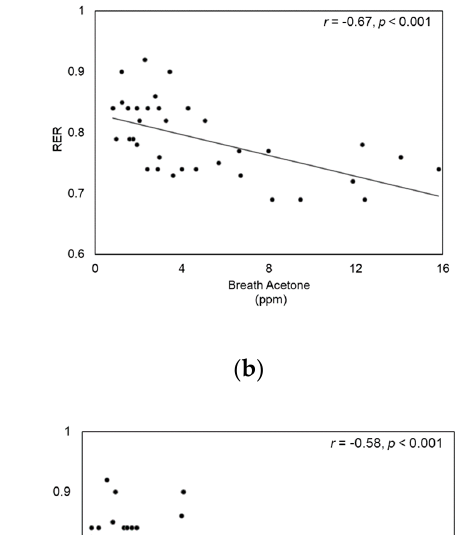
Figure 2. Monitoring of ( a ) Breath acetone, ( b ) β -hydroxybutyrate, ( c ) Acetoacetate, and ( d ) Free fatty acid.